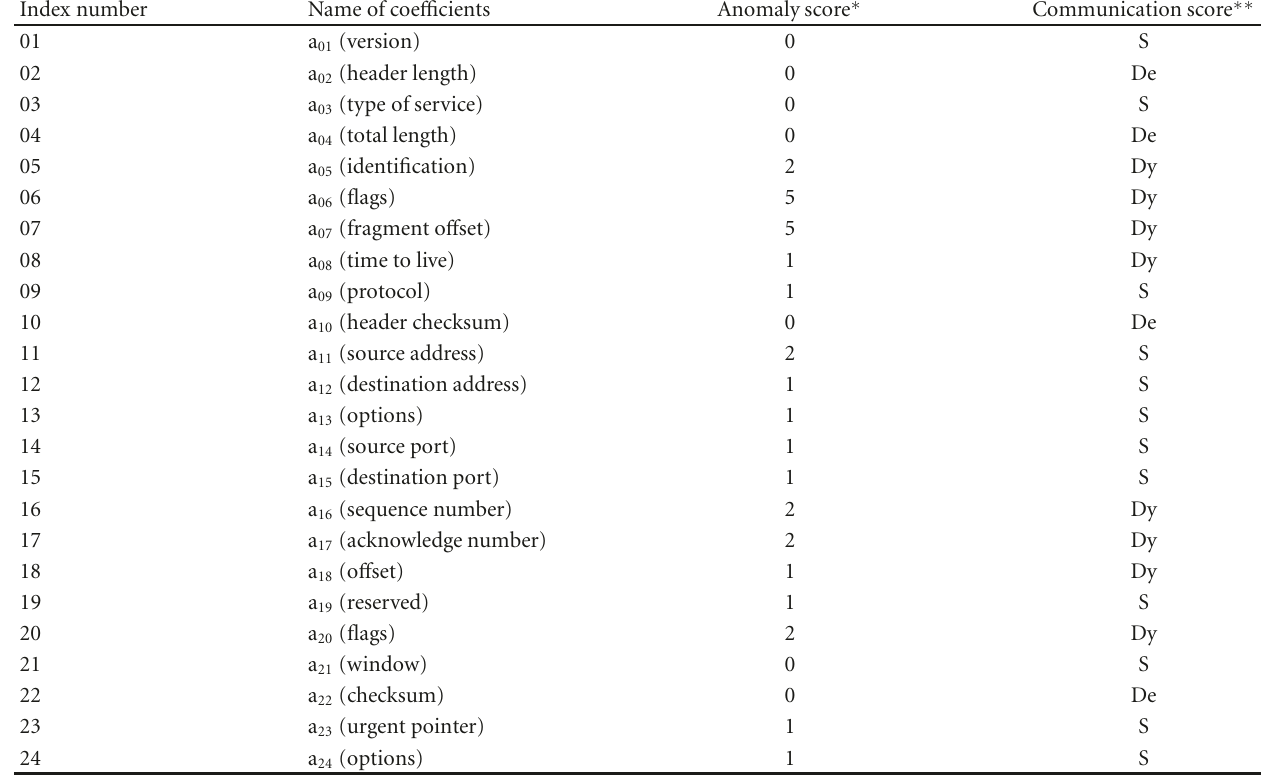
Table 1: TCP/IP anomaly and communication